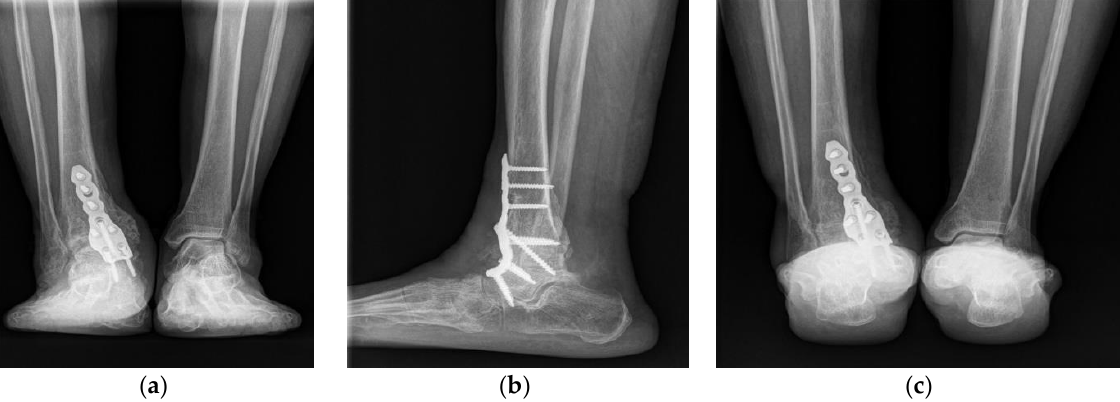
Figure 8. Postoperative plain anteroposterior ( a ), lateral ( b ), and heel alignment ( c ) radiographs at the 5-month follow-up examination showing complete fusion and corrected alignment.